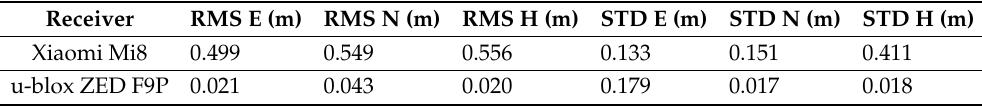
Figure 7. ( a ) Scatter plot of the positioning error for Xiaomi Mi8 and u − blox ZED F9P; ( b ) time series of the positioning error for Xiaomi Mi8 and u − blox ZED F9P. Table 2. Test 2: Post-processing